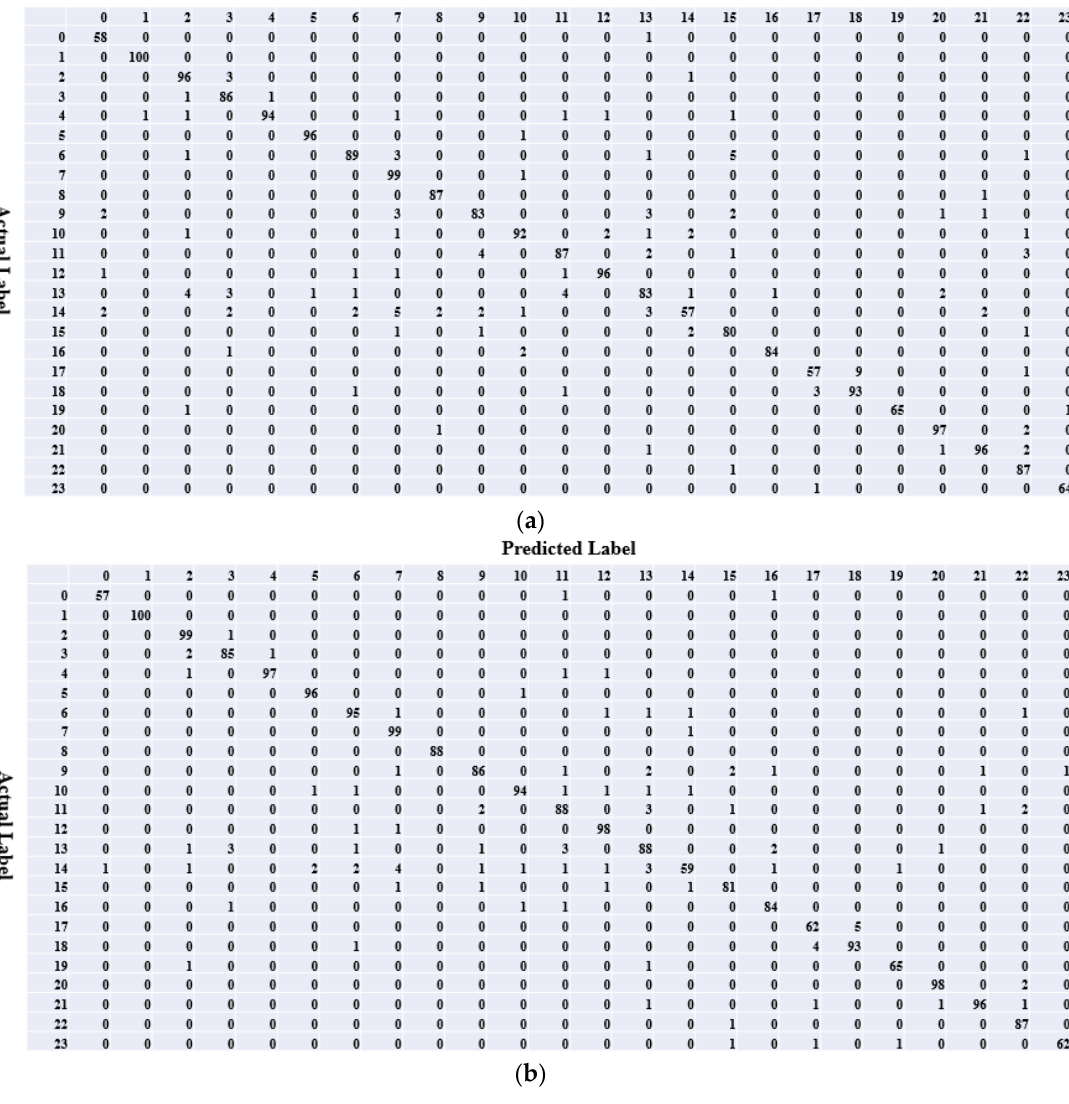
Figure 12. Comparison of confusion matrix: ( a ) Weakly DenseNet-19; ( b ) BridgeNet-19.